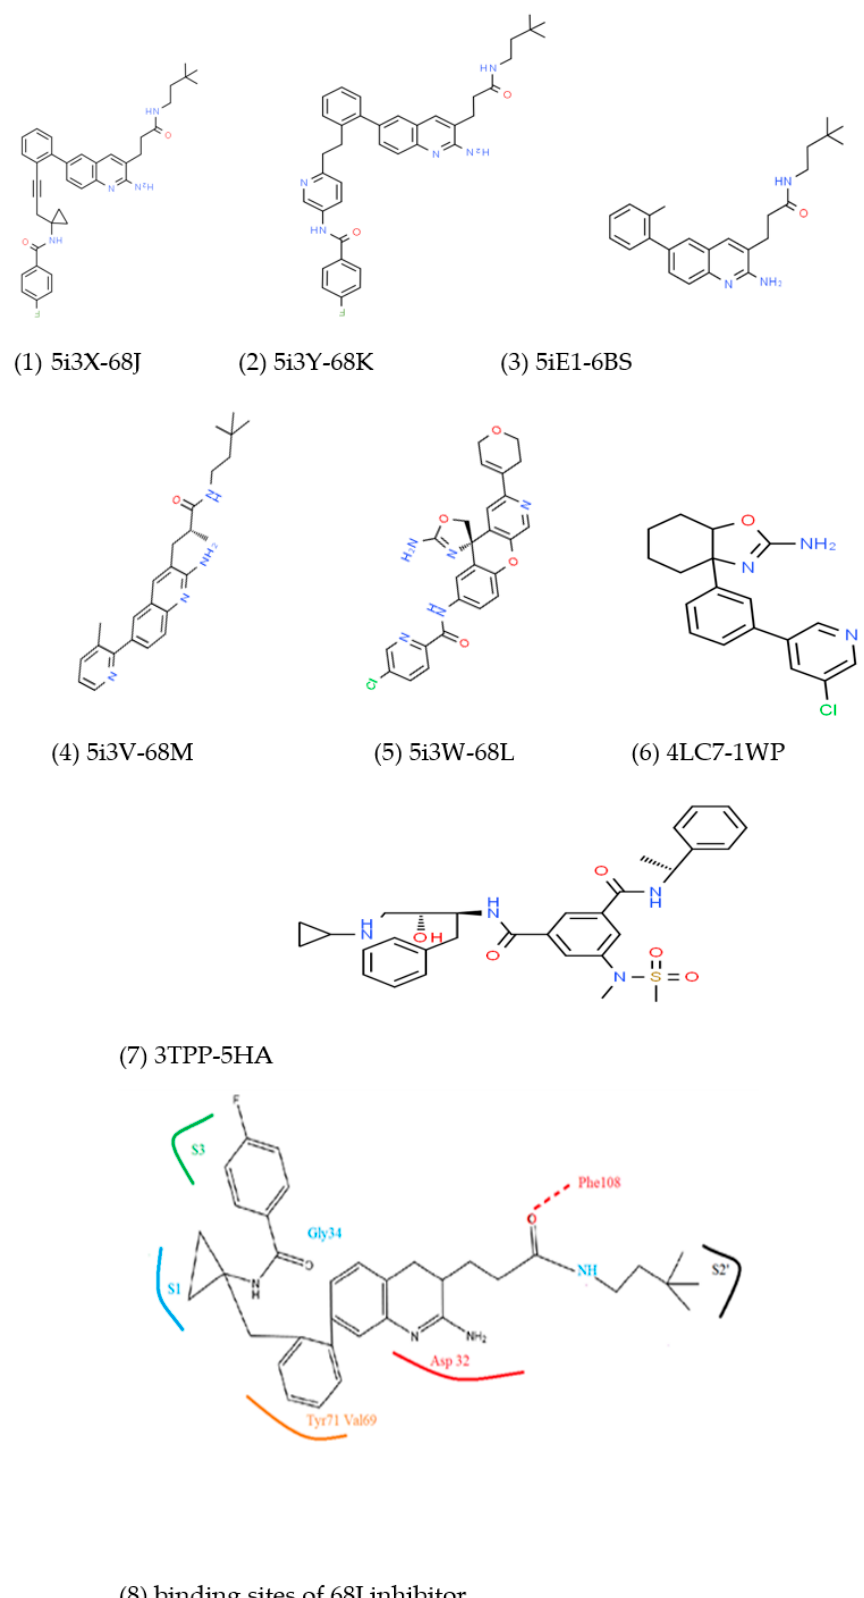
Figure 3. Structures 1 to 7 are selected BACE1 inhibitors with their PDB ID. Structure (8) shows the binding mode of inhibitors derived from MD simulation using 68J as an example.